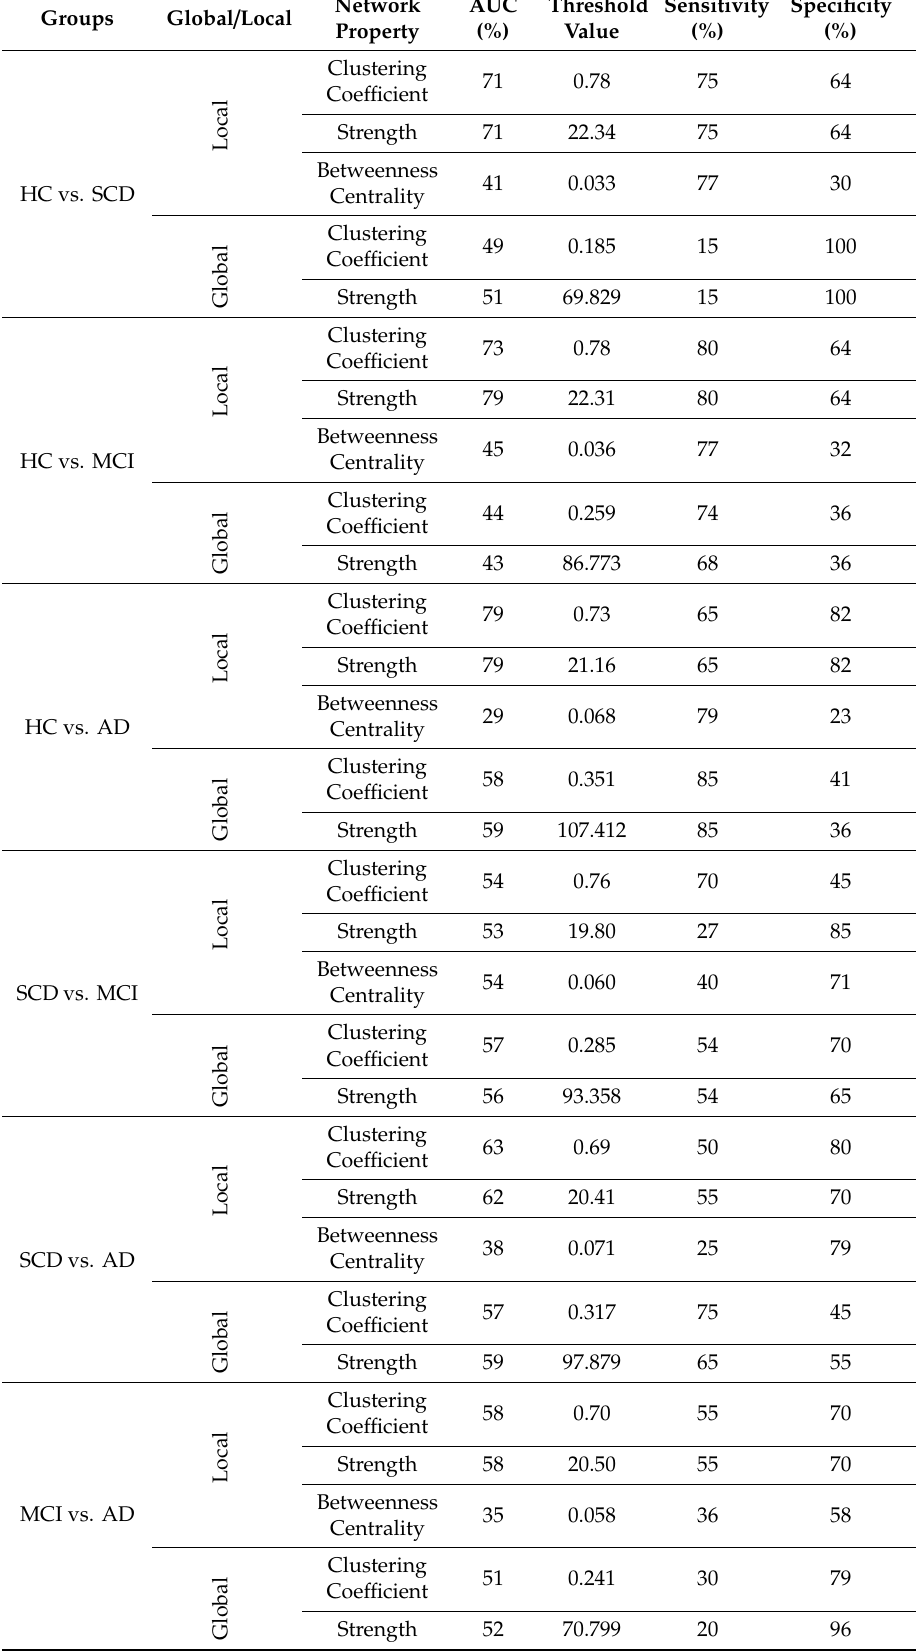
Table 5. Sensitivity and specificity of clustering coe ffi cient, strength and betweenness centrality at global and local levels for all di ff erent combinations of one to one